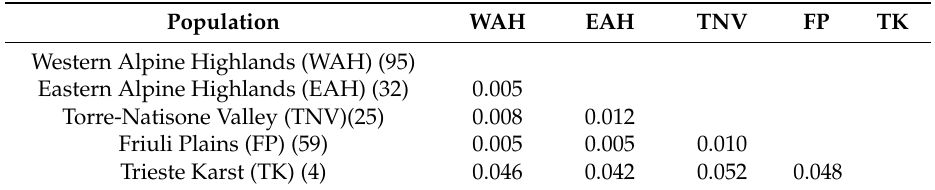
Figure 3. Inference of K, the most probable number of clusters, using STRUCTURE software, based on microsatellite analysis of 215 walnut samples. ( A ) Plot of mean likelihood L(K) and variance per K value from STRUCTURE on a dataset containing 215 individuals genotyped for 20 polymorphic microsatellite loci over 20 runs for each K value. ( B ) Plot of the ad hoc statistic Δ K, which is based on the rate of change of the log ‐ likelihood as K is increased)[50] Δ K tends to peak at the value of K that corresponds to the highest level of hierarchical substructure. The modal value of this distribution is the true K, here two clusters.